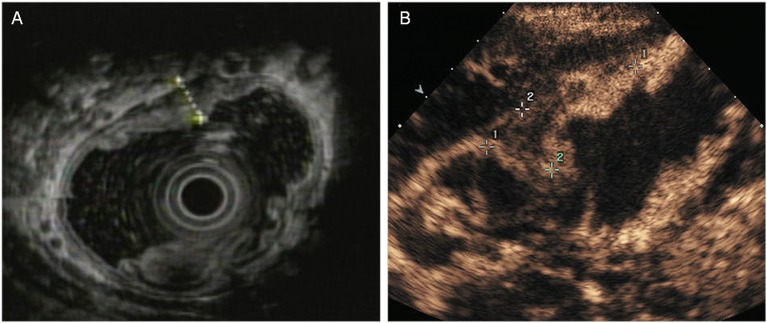
A case with T2 tumor located in the anterior wall of the gastric body. (A) EUS showed an ulcerative lesion involving the muscularis propria (fourth layer). The serosal layer appears intact. (B) DCEUS image showed the lesion invaded into the muscularis propria. The lesion didn't penetrate the serosa.